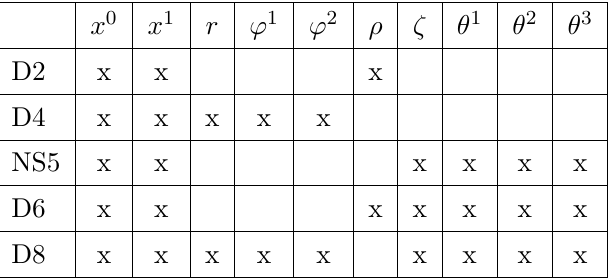
-BPS brane intersection underlying the N = (0 , 4) AdS solutions (2.4). ( x 0 , x 1 ) are Table 1 . 1 3 8 the directions where the 2d dual CFT lives, ( r, ϕ i ) are spherical coordinates spanning the 3d space previously parameterised by ( z ) , ζ is the radial coordinate of AdS and θ i parameterise the S 3 . 1 , z 2 , z 3 3 Imamura’s D6-NS5-D8 flat-space intersection [72] is described by the